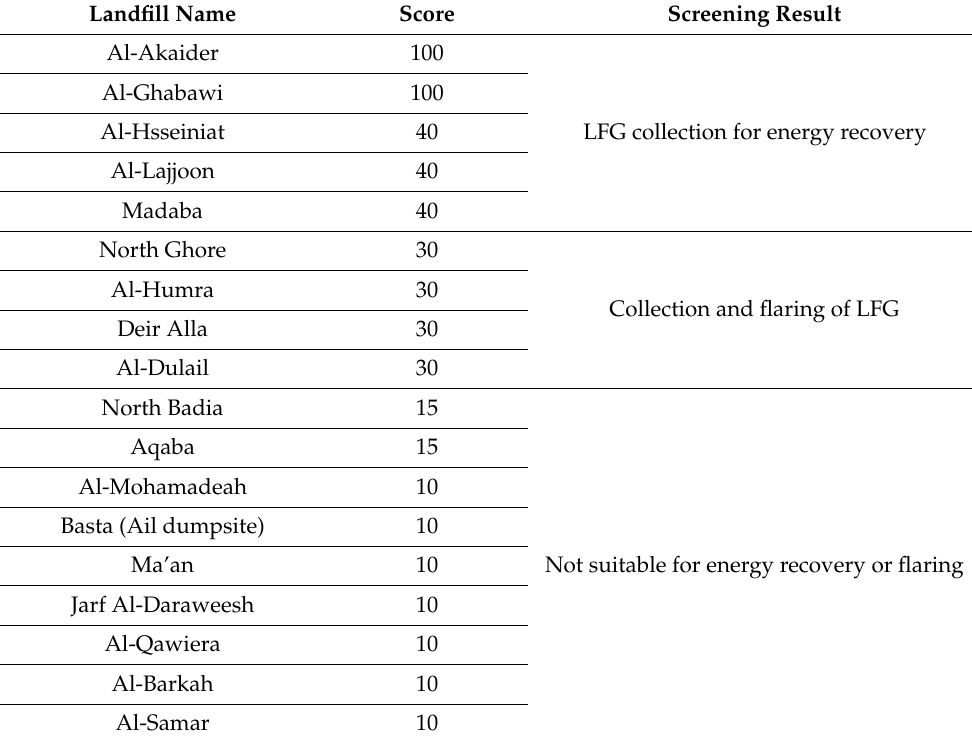
Table 2. Screening results of landfills for suitability of landfill gas recovery.